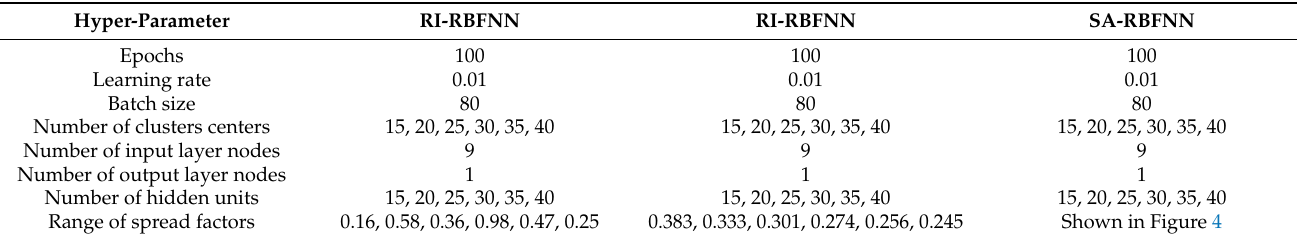
Table 1. Hyper-parameters setting of comparative RBFNN based